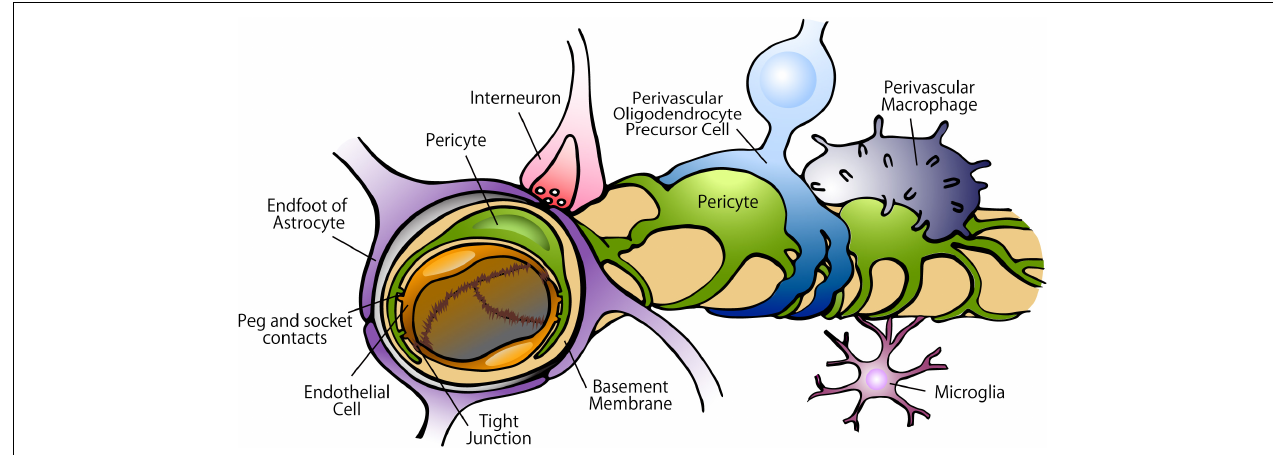
FIGURE 2 | Constituents of the BBB in the capillary. In the BBB, tight junctions created by endothelial cells strictly regulate the movement of ions, molecules, and cells between the blood and the brain. The tight junctions are controlled by the cells surrounding the endothelium, including pericytes, astrocytes, perivascular OPCs, interneurons, perivascular macrophages, and microglia. Pericytes are localized on the abluminal surface of the endothelial layers and embedded in the basement membrane. Astrocytes extend polarized cellular processes that almost completely ensheath the vessel